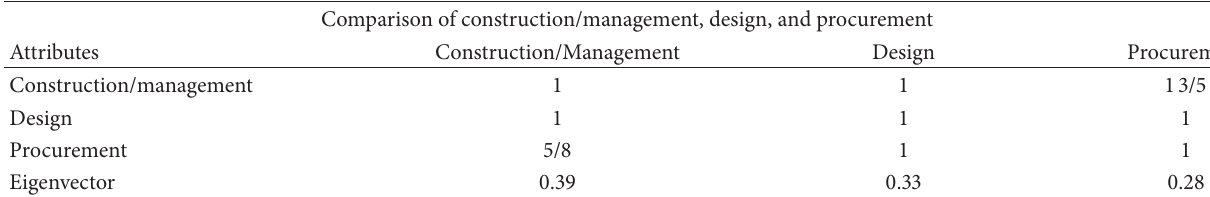
Table 4: Weighting value of main criteria.